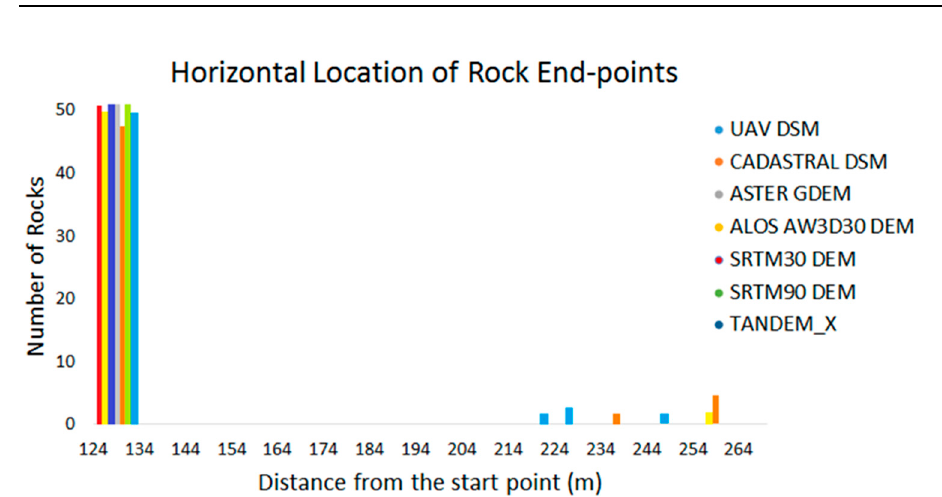
Figure 12. Horizontal location of rock end points for the 2nd slope profile.